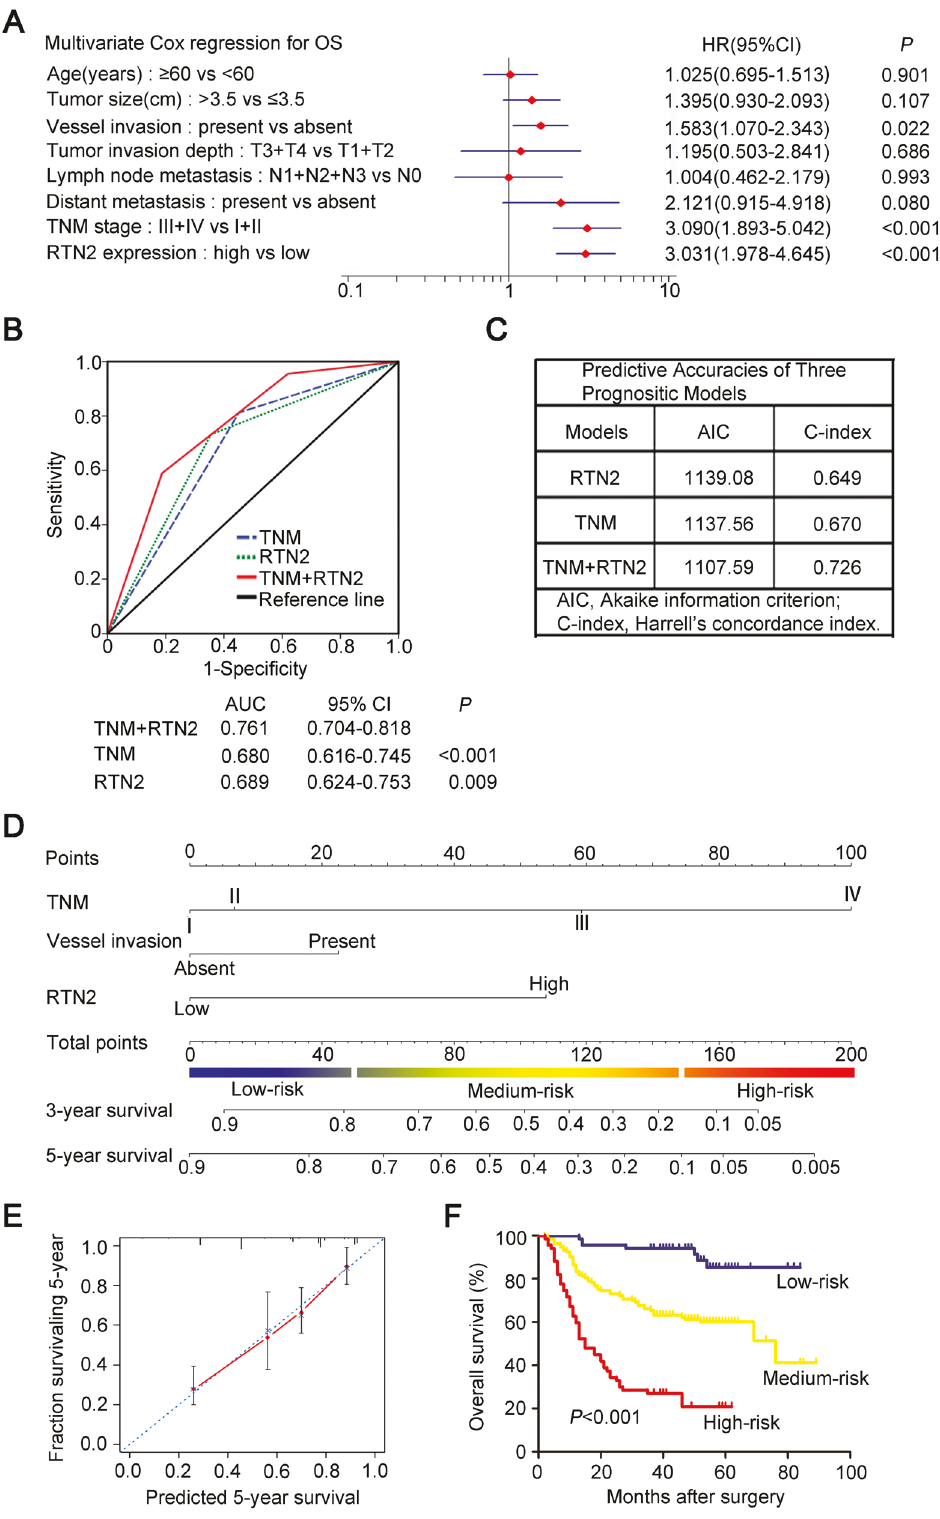
Fig. 2 RTN2 expression is an independent factor that could improve predictive accuracy in gastric cancer patients. A Multivariate Cox analysis was performed to identify independent prognostic factors in patients with gastric cancer. B ROC analysis of the sensitivity and speci fi city for the predictive value of TNM model, RTN2 expression model and the combined model. C The predictive accuracies of TNM staging, RTN2 expression and the combined model were compared by AIC and C-index. D Nomogram was utilised to quantify the integrated effect of the proven independent prognostic factors for overall survival. E Calibration plot of the nomogram for 5-year survival. F Of all 267 patients, three groups were divided according to the total points in the nomogram which range of 0 – 50, 51 – 150, 151 – 200, was de fi ned as low-, medium- and high-risk subgroup, respectively. Kaplan – Meier analysis was used to test the correlation of the risk with overall survival. Statistical signi fi cance was calculated by multivariate Cox analysis ( A ) and log-rank test ( F ). Cell Death and Disease (2022)